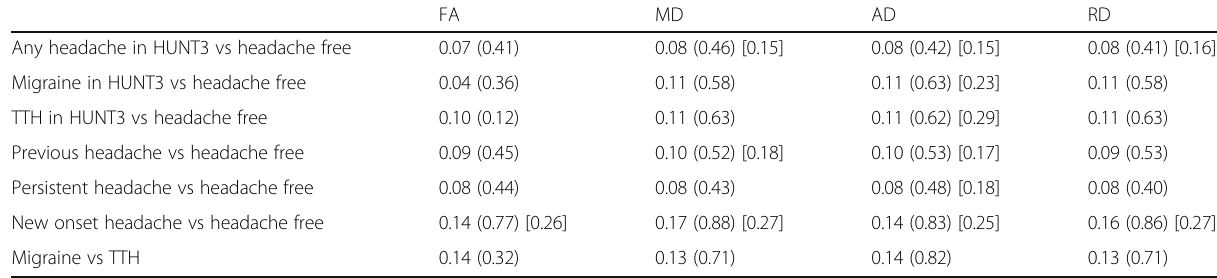
Table 3 Mean Cohen ’ s d values of the TBSS analyses corrected for age and sex. In parenthesis are peak Cohen ’ s d values and in brackets are mean Cohen ’ s d values when considering only the significant voxels FA MD AD RD Any headache in HUNT3 vs headache